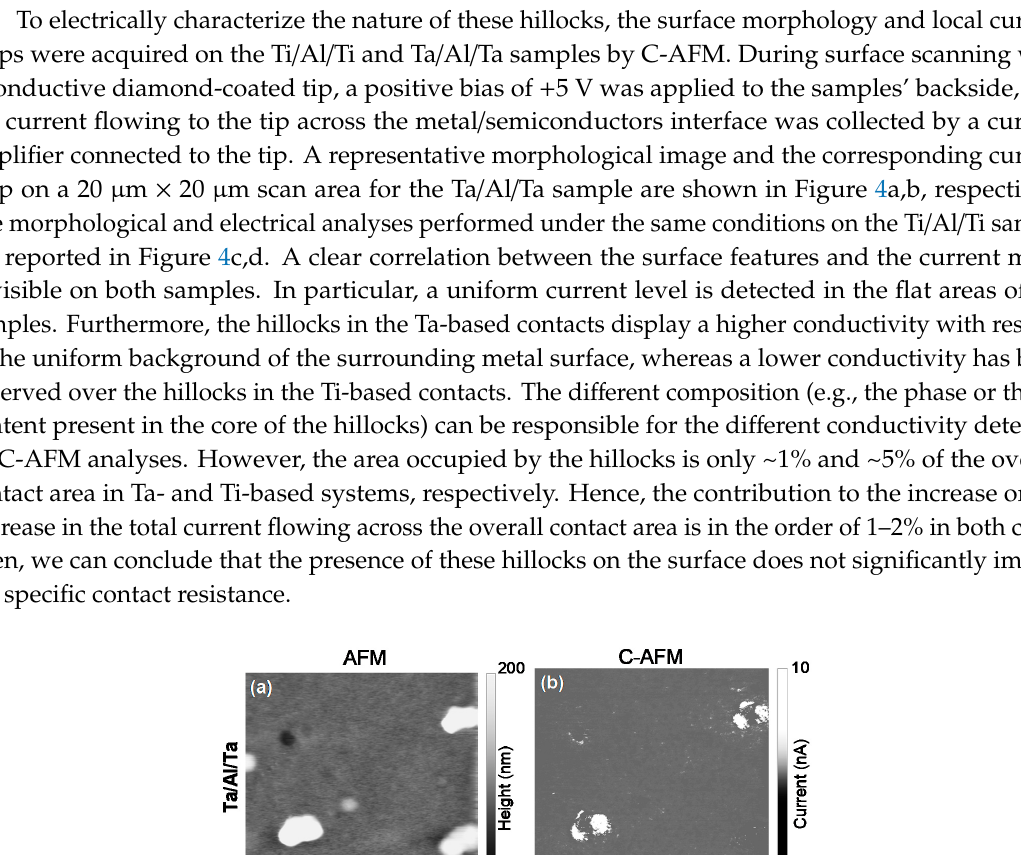
Figure 5. X-ray diffraction (XRD) patterns for Ta/Al/Ta and Ti/Al/Ti contacts annealed at 600 °C, showing the appearance of the Al 3 Ta and Al 3 Ti phases.